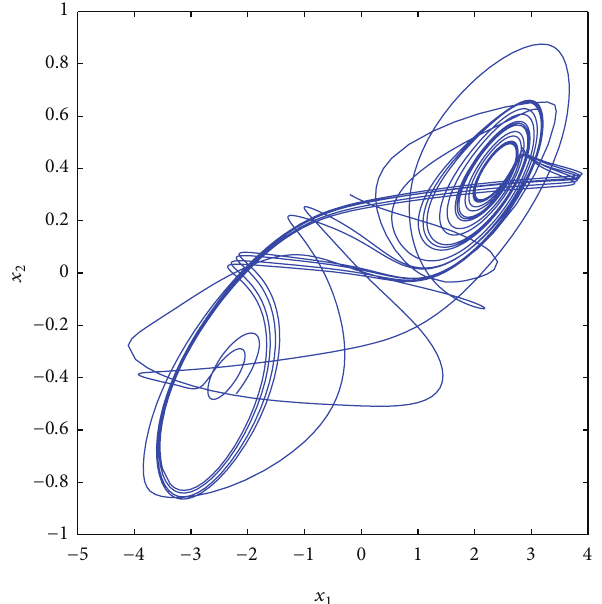
Figure 1: The chaotic attractor of the Lu oscillator described by (30) with initial value 𝑥 1 (𝑠) = 0.2 , 𝑥 2 (𝑠) = −0.5 , for 𝑠 ∈ [−1, 0] .